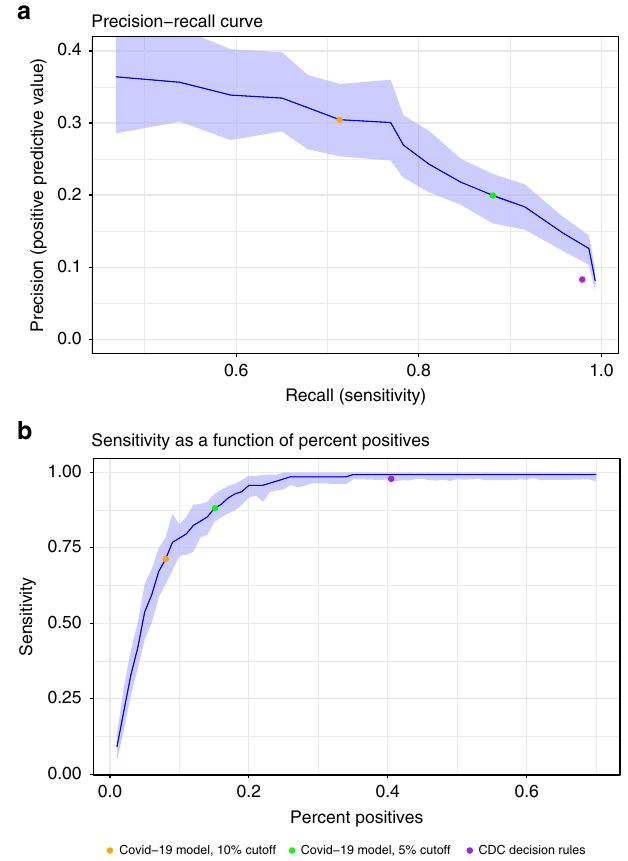
Fig. 3 Performance charts for the COVID-19 model. a A plot of the positive predictive value against the sensitivity of the predictor for different thresholds. The central line represents the point estimates from the full population. The light band around the line represents point-wise 95% con fi dence intervals derived by bootstrapping. Only thresholds up to 15% absolute risk were plotted because of very low outcome rates in higher thresholds, which resulted in instability. The colored dots show the performance of three binary classi fi ers. b A plot of the sensitivity against the percent of patients identi fi ed as high risk for different thresholds. The central line represents the point estimates from the full population. The light band around the line represents point-wise 95% con fi dence intervals derived by bootstrapping. The colored dots show the performance of three binary classi fi ers. Both panels use the COVID-19 patient population, n = 4179 unique patients. CDC Centers for Disease Control and prevention, COVID-19 coronavirus disease